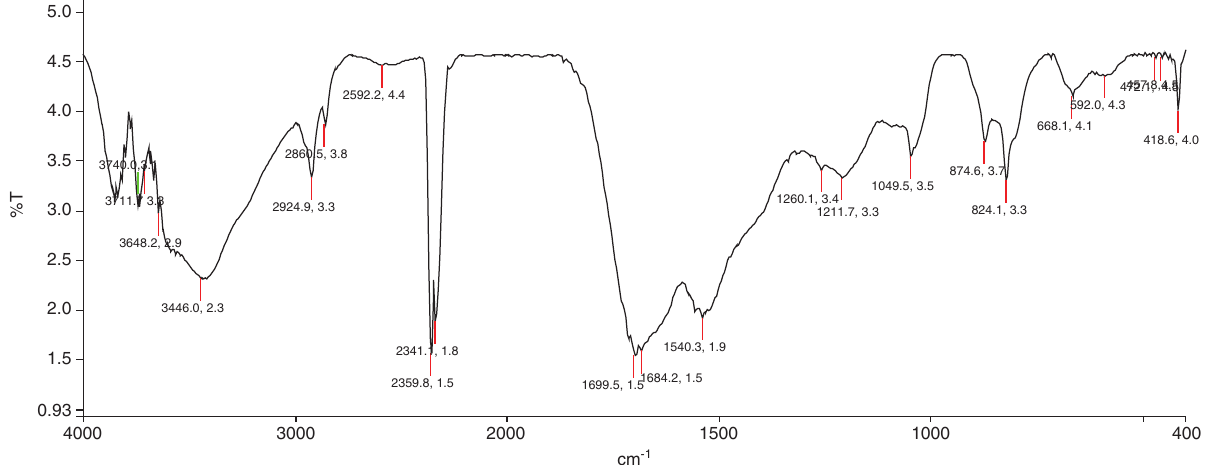
Figure 4 FTIR spectra for catalyst obtained using hydrothermal carbonization and sulfonation of the commercially available